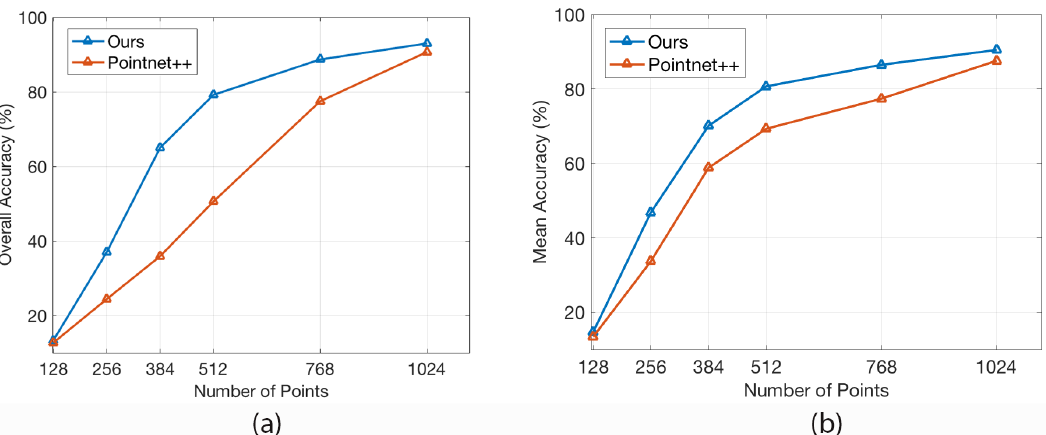
Figure 6. Classification accuracy of our model and PointNet++ with a different number of input points on ModelNet40 test data. ( a ) Overall accuracy across all instances. ( b ) Average of per-class accuracy. The experiments were done without